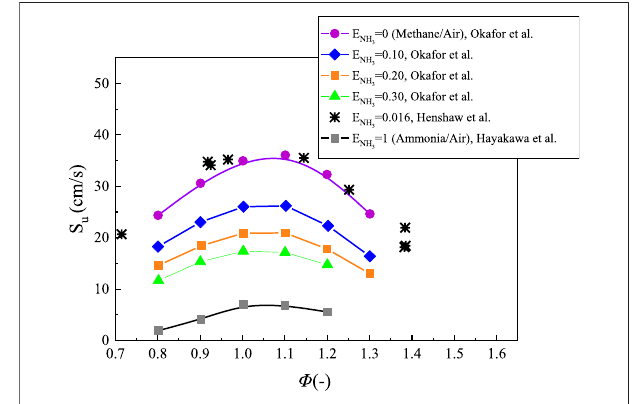
FIGURE 8 | Laminar burning velocity of NH 3 fl ame with a function of equivalence ratio at various ammonia addition in Methane/ammonia/air fl ames, replotted from (Okafor et al., 2018; Henshaw et al., 2005; Hayakawa et al.,